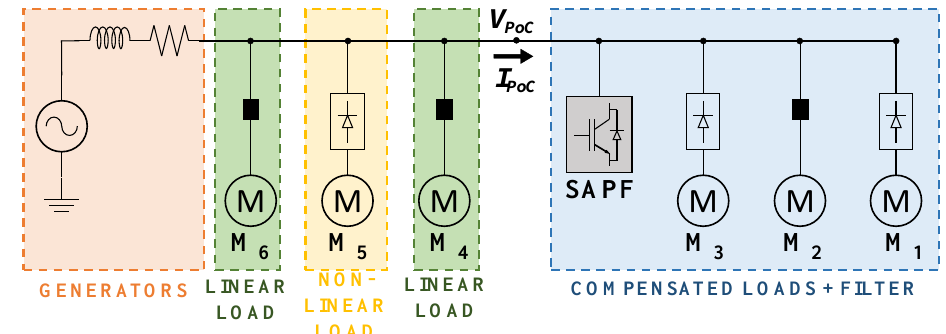
Figure 4. Equivalent model of the electric grid of Figure 1.